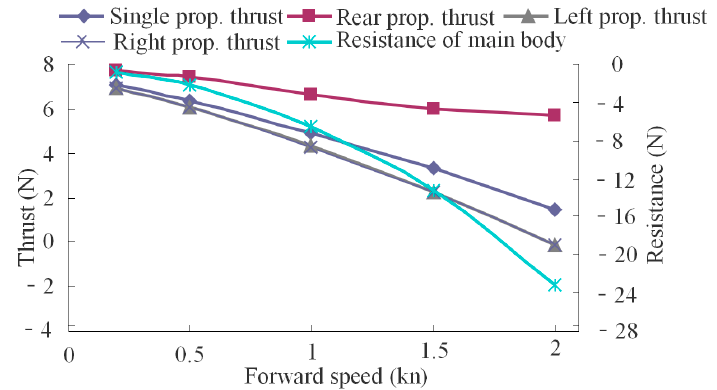
Figure 13. Straight advance of each propeller thrust